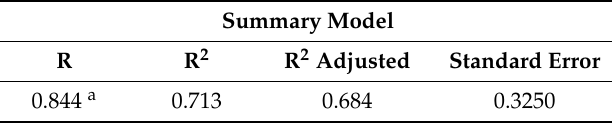
Table 3. Determination coefficients: In-situ density and topographic settlement.